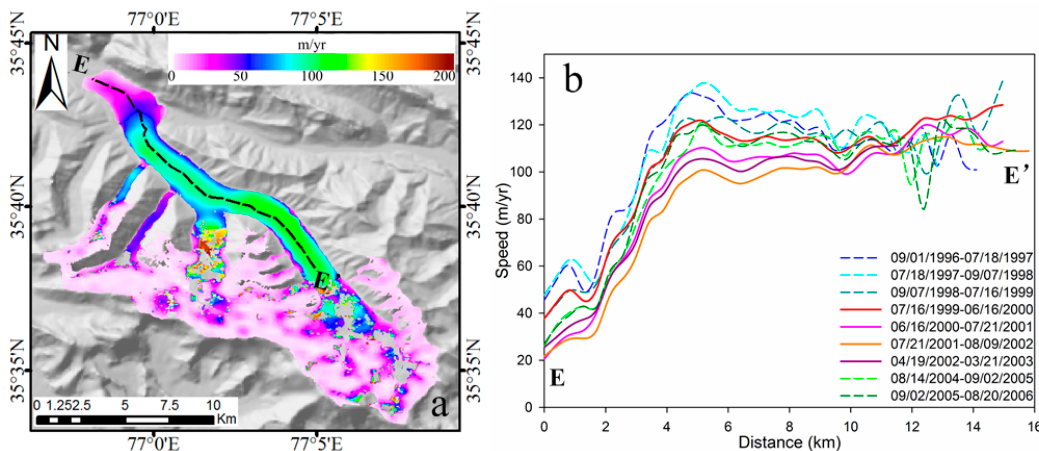
Figure 7. ( a ) Surface velocity over the Singkhu Glacier (2001–2002) and EE’ is the centerline of the Singkhu Glacier; ( b ) Annual speed profiles along the centerline (EE’) of the Singkhu Glacier from 1996 to